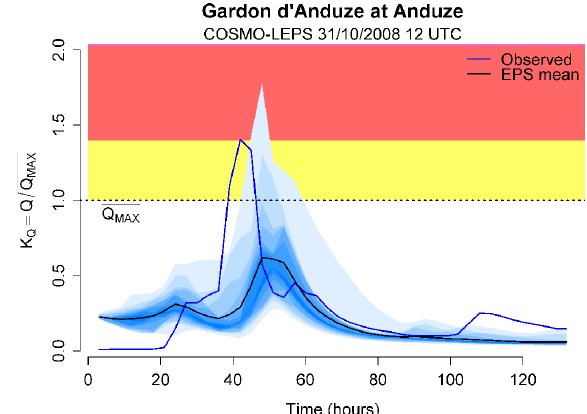
Fig. 3. Ensemble discharge forecast for the Gardon d’Anduze at Anduze (blue shadings around the median) and observations (blue line) for the 31 October 2008 forecast. Rescaled values are plot- ted for coherent comparison. Medium and high warning ranges are shown in yellow and red, respectively.